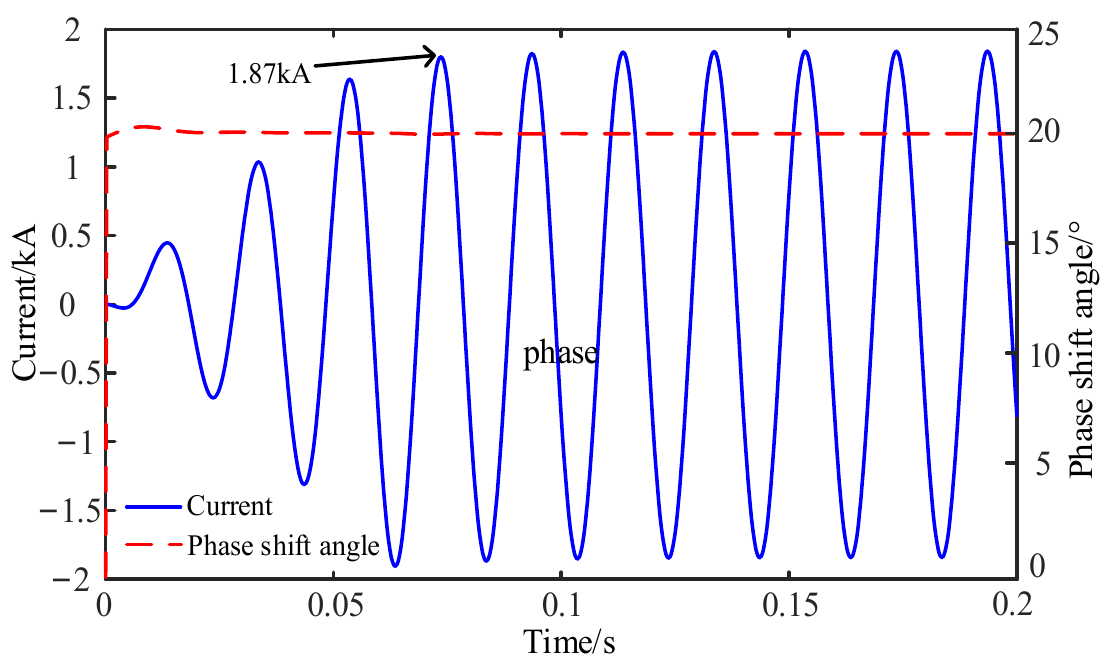
Figure 12. Performance verification of PST .